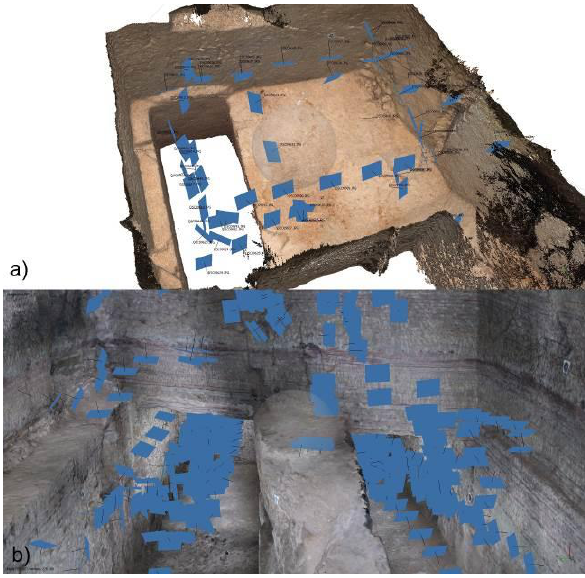
Figure 6. Distribution of photographs in: a) QH32 Intermediate chambers; b) QH33 Burial